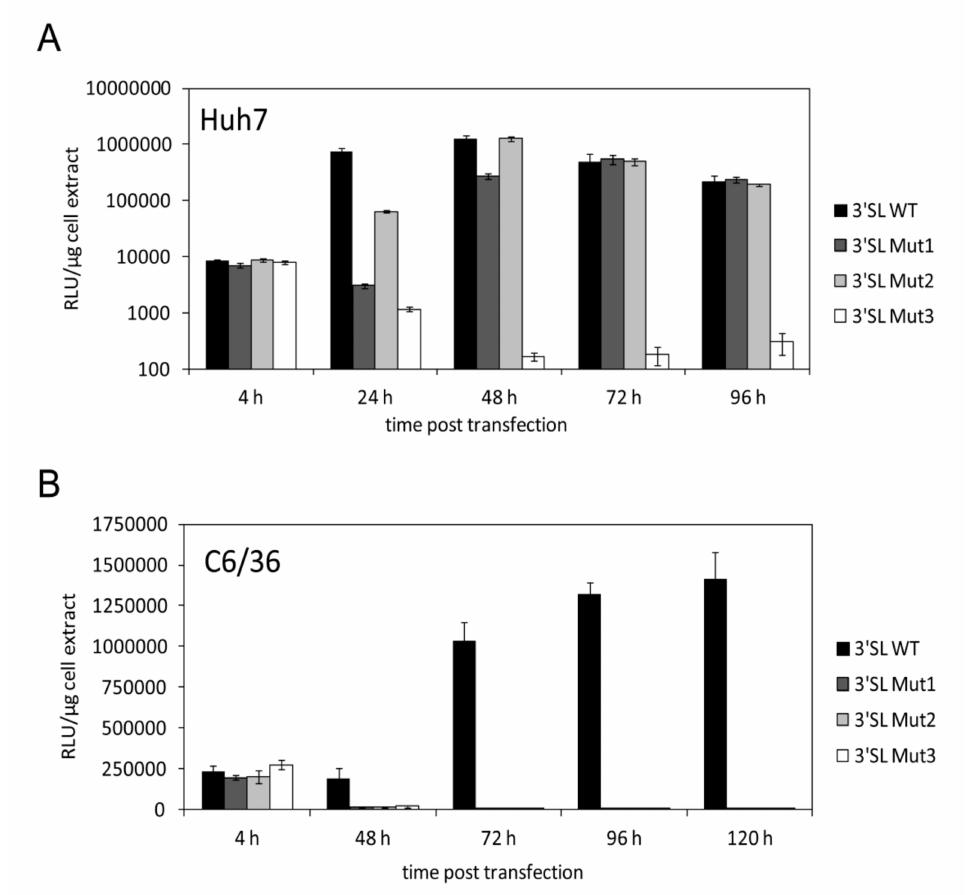
Figure 3. Altering the stability of the WNV 3 (cid:48) SL a ff ects RNA replication di ff erently in human and mosquito cells. ( A ) Huh7 cells were transfected with wild-type and mutant WNVRluc replicon RNAs, cultivated at 37 ◦ C and analyzed for luciferase reporter activity at the indicated time points post transfection. Results from one representative experiment performed in triplicate are shown and error bars reflect standard deviations. ( B ) Same as in (A) except that C6 / 36 cells were used and cultivated at 28 ◦